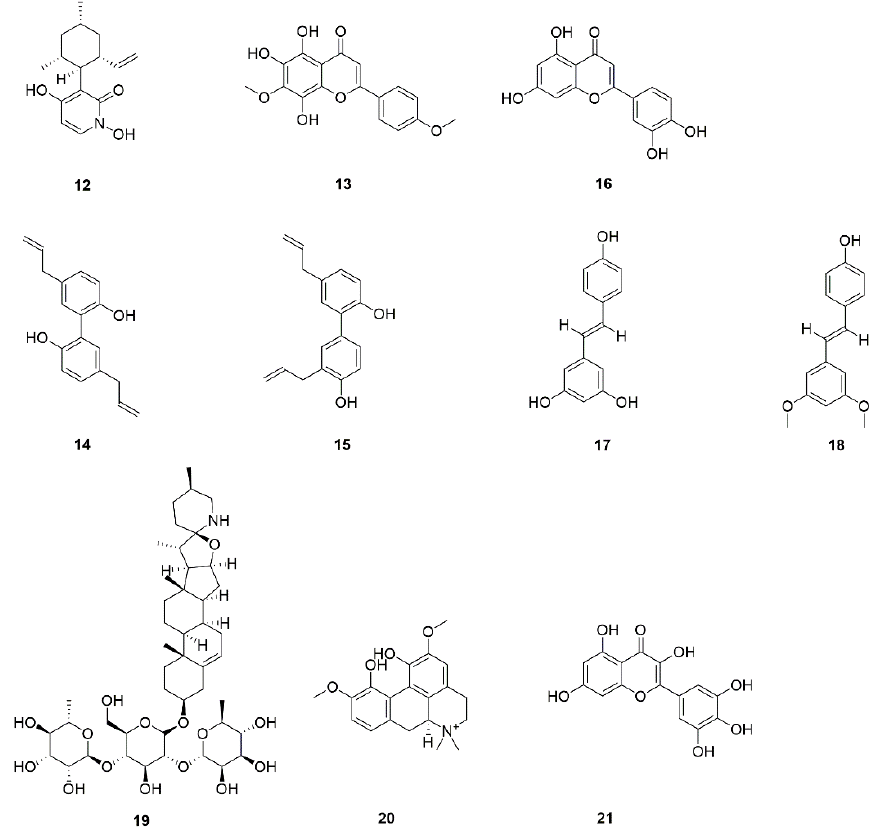
Figure 6. Chemical structures of natural compounds targeting biofilm formation.